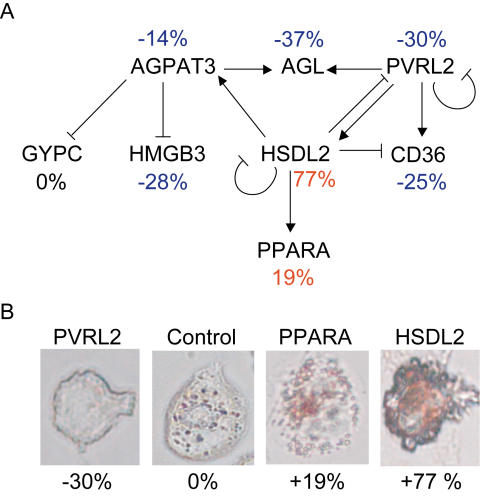
A regulatory gene network of foam-cell formation.Twelve cholesterol-responsive atherosclerosis genes (Table S12, in bold) were targeted in THP-1 macrophages using siRNA. Two days after transfection, siRNA-targeted macrophages and controls treated with nonspecific siRNA were incubated with AcLDL (50 µg/mL) for 48 hours; total RNA was isolated, and CE and lipid accumulation were determined. (A) Sixteen expression profiles (HG-U133_Plus_2 arrays, Affymetrix) from 12 siRNA experiments and four pooled controls were used to generate the regulatory gene network (Results) of 8 cholesterol-responsive genes involved in foam-cell formation, including PPARA and CD36. CE accumulation (given as average percentage next to each node) was decreased (blue) by siRNA inhibition of 5 genes and increased (red) by inhibition of 2 genes; inhibition of 1 gene had no effect (black) (see also Table 3). (B) Representative siRNA treated THP-1 cells after 48 incubation with AcLDL and stained with Oil-red-O.